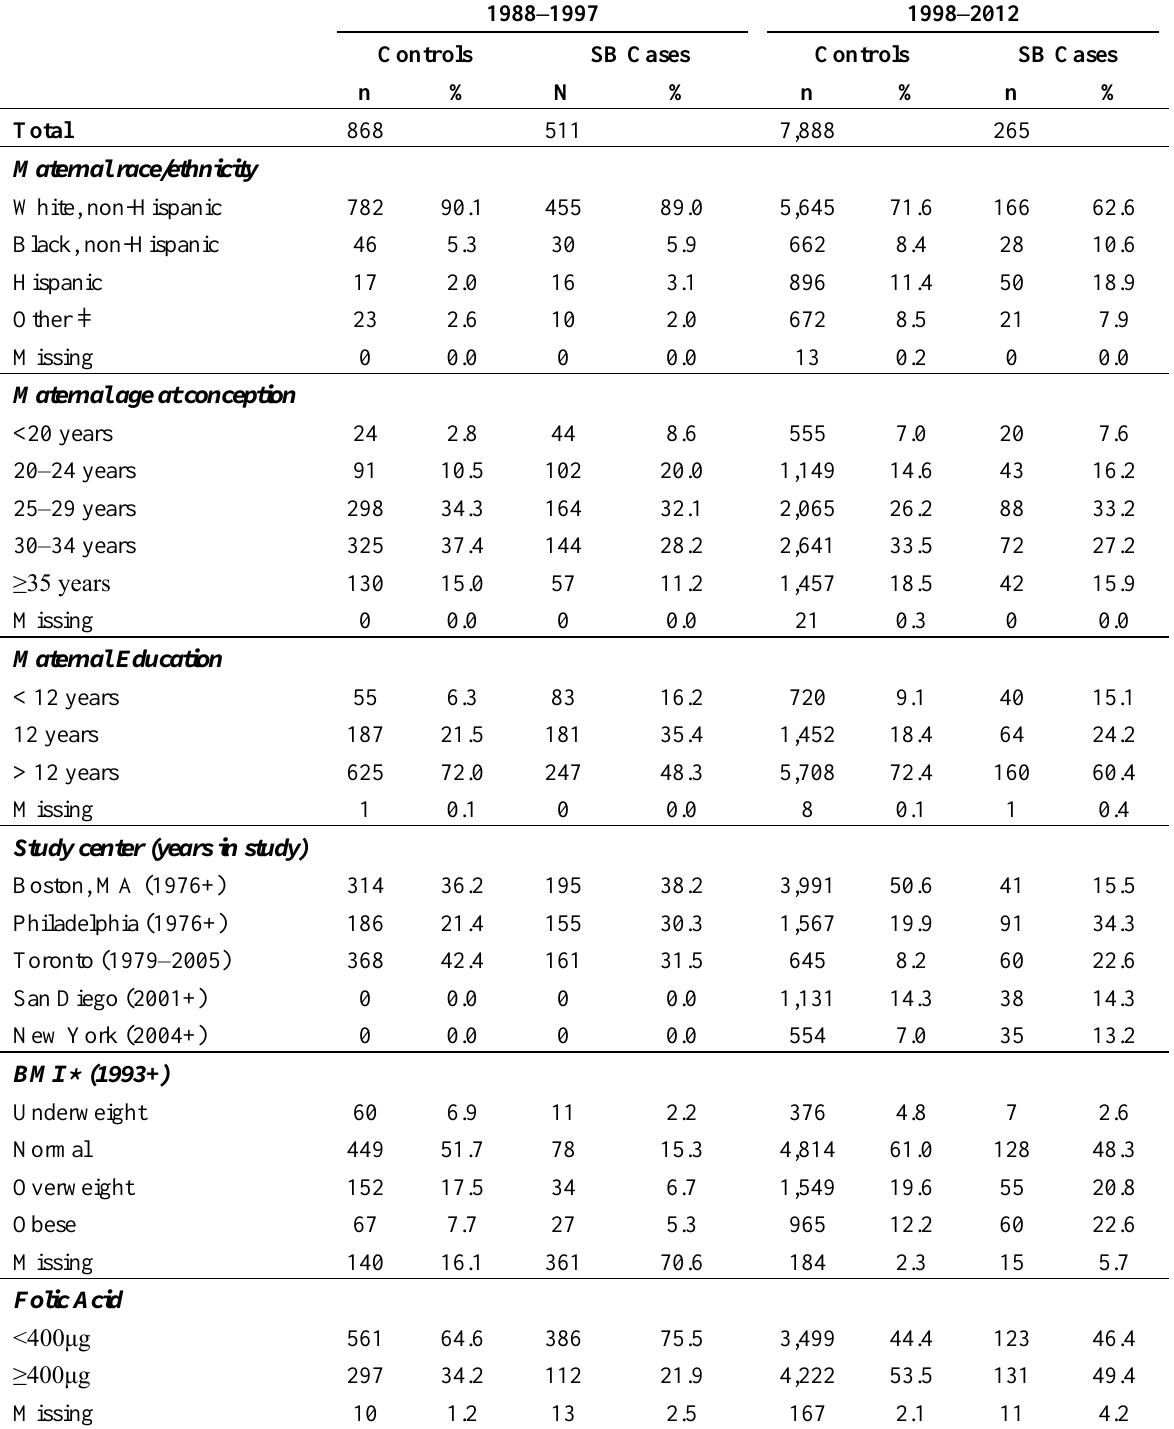
Table 1. Maternal Demographics of Spina Bifida Cases and Controls, Birth Defects Study,